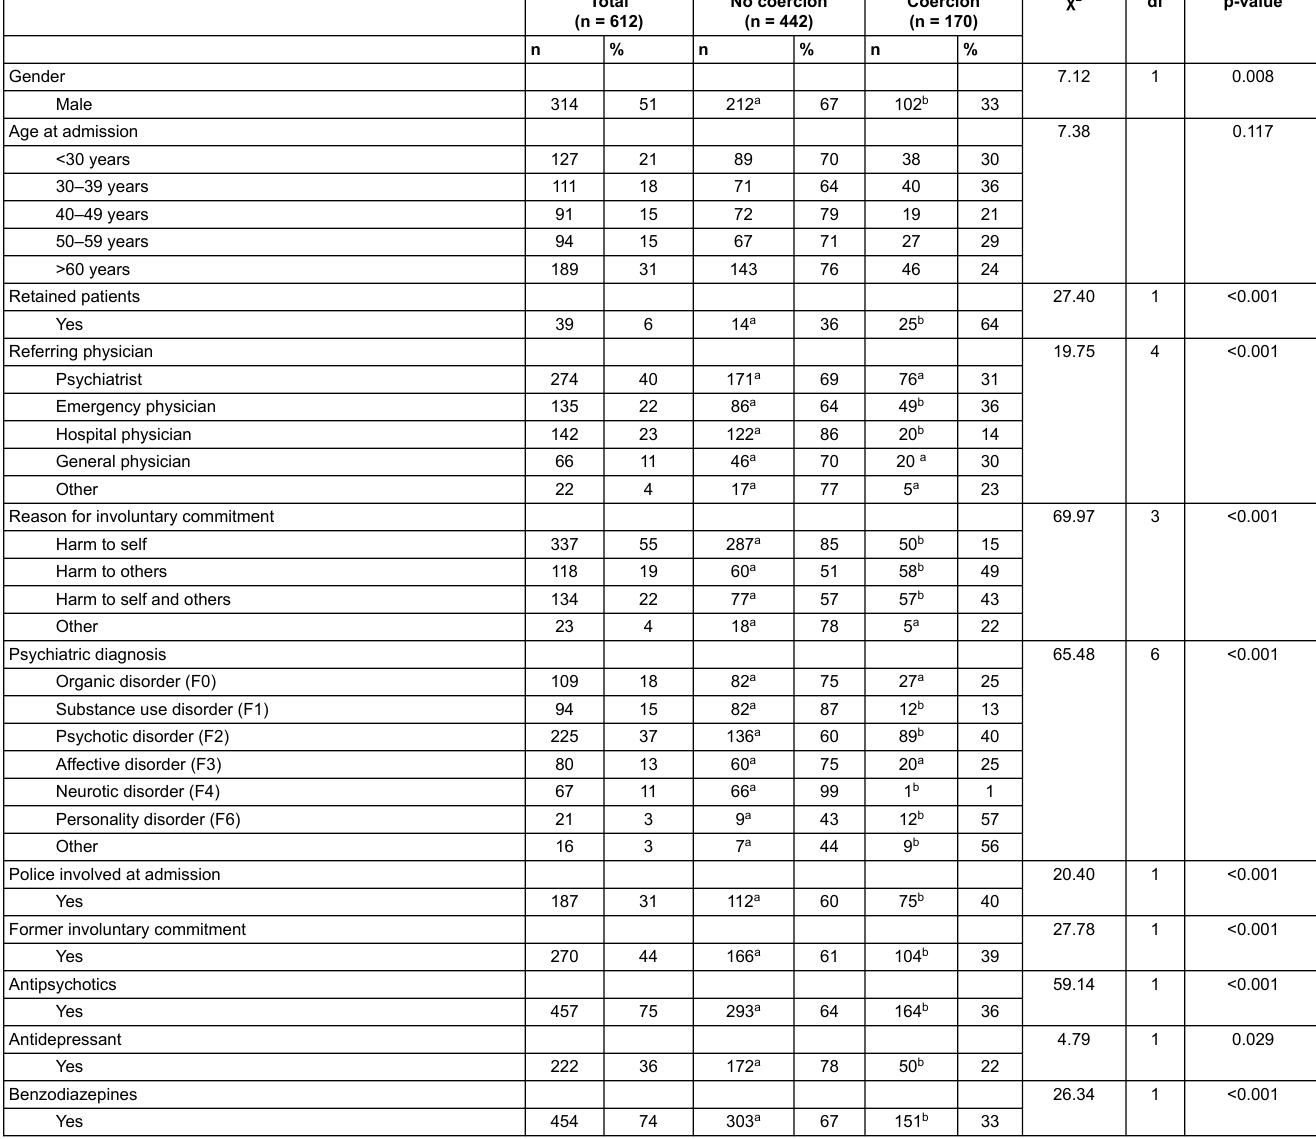
Table 3: Comparison of patients’ characteristics with/without coercion of clinical and procedural parameters.